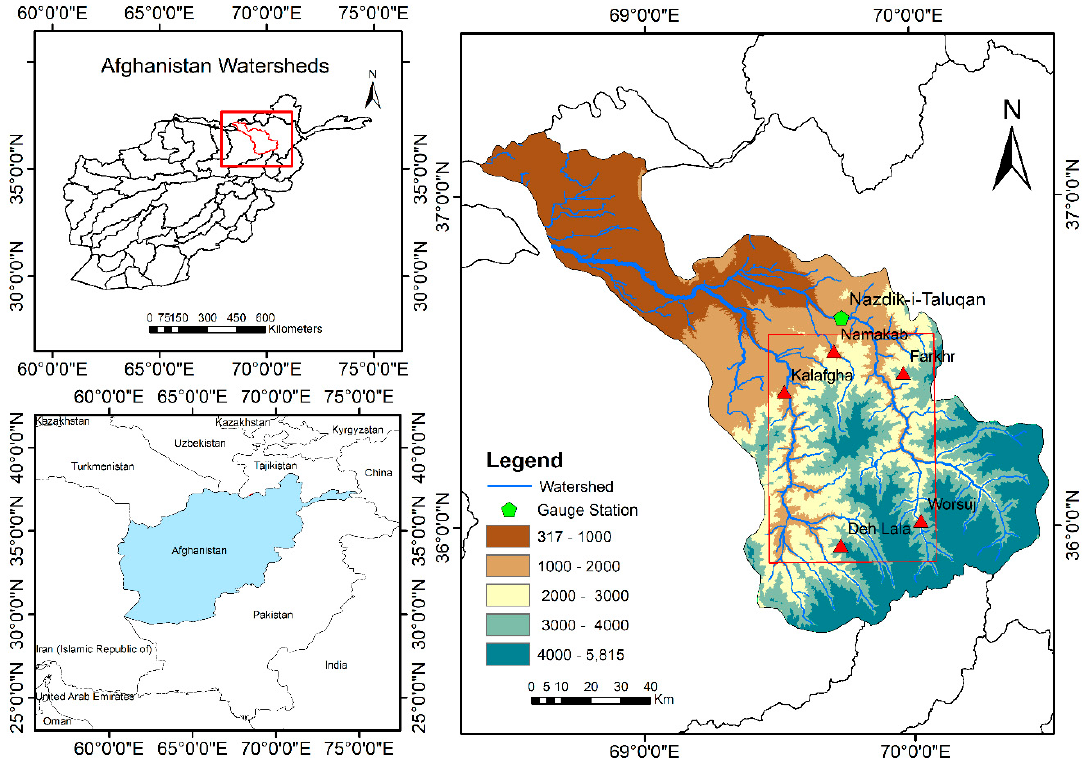
Figure 1. Study area with annotated location of the field campaigns (Kalafgan and Worsaj) and other prominent locations in the Khanabad watershed of northern Afghanistan. Table 1. Sentinel-1 C-band dual polarimetric and interferometric synthetic aperture radar (SAR) datasets were used in this study.